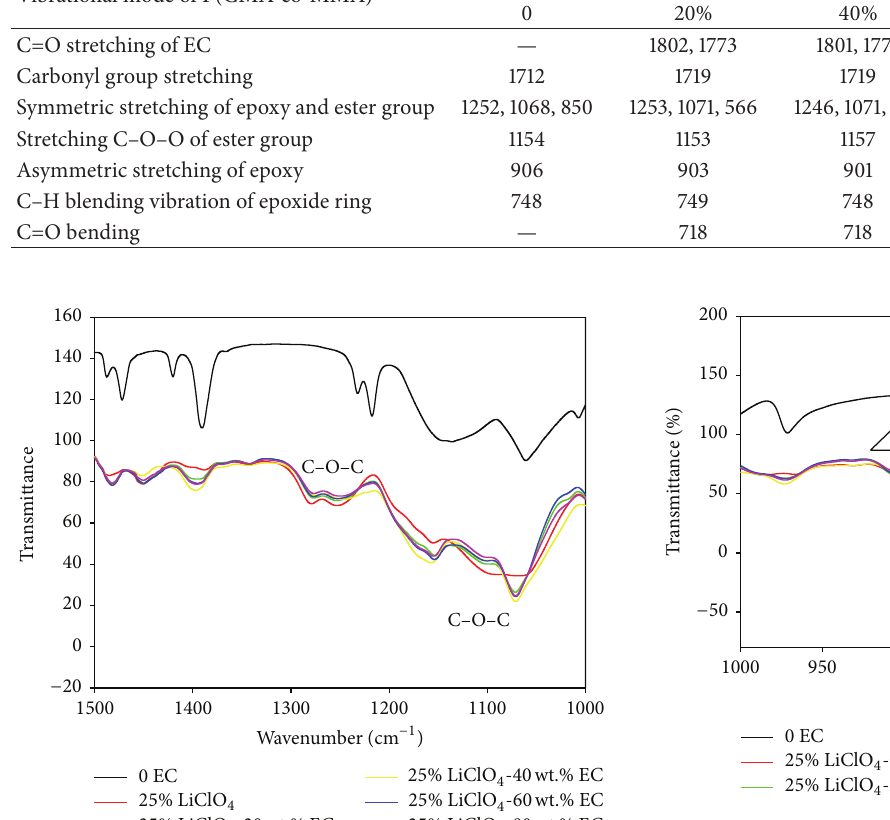
Table 1: Vibrational mode assignments of P(GMA-co-MMA)-25% LiClO Vibrational mode of P(GMA-co-MMA)